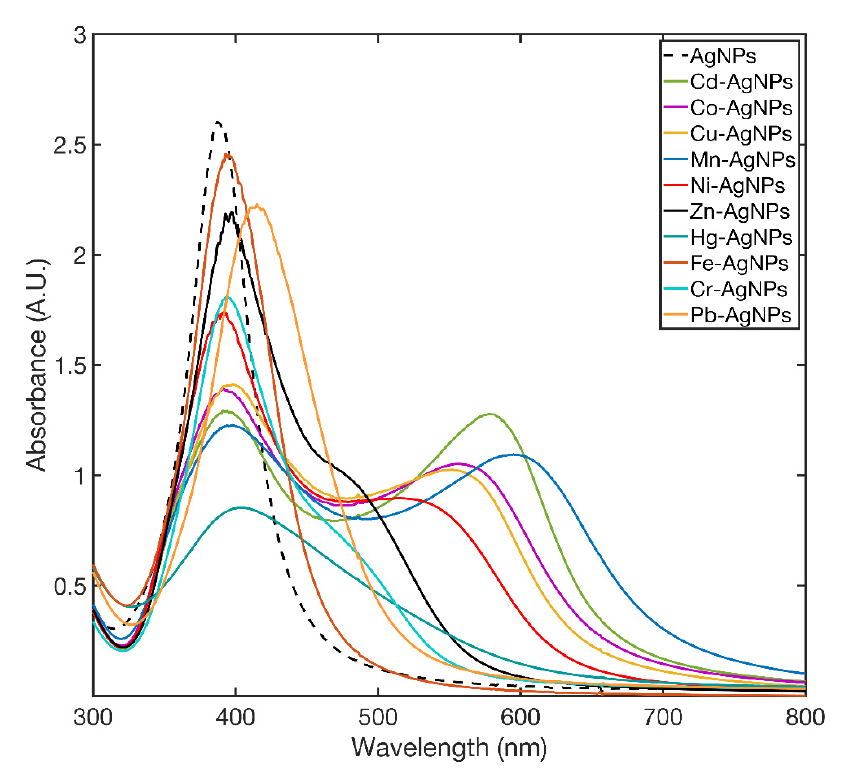
Figure 5. SPAB spectra of AgNPs recorded at 5 min after the addition of metal ions.